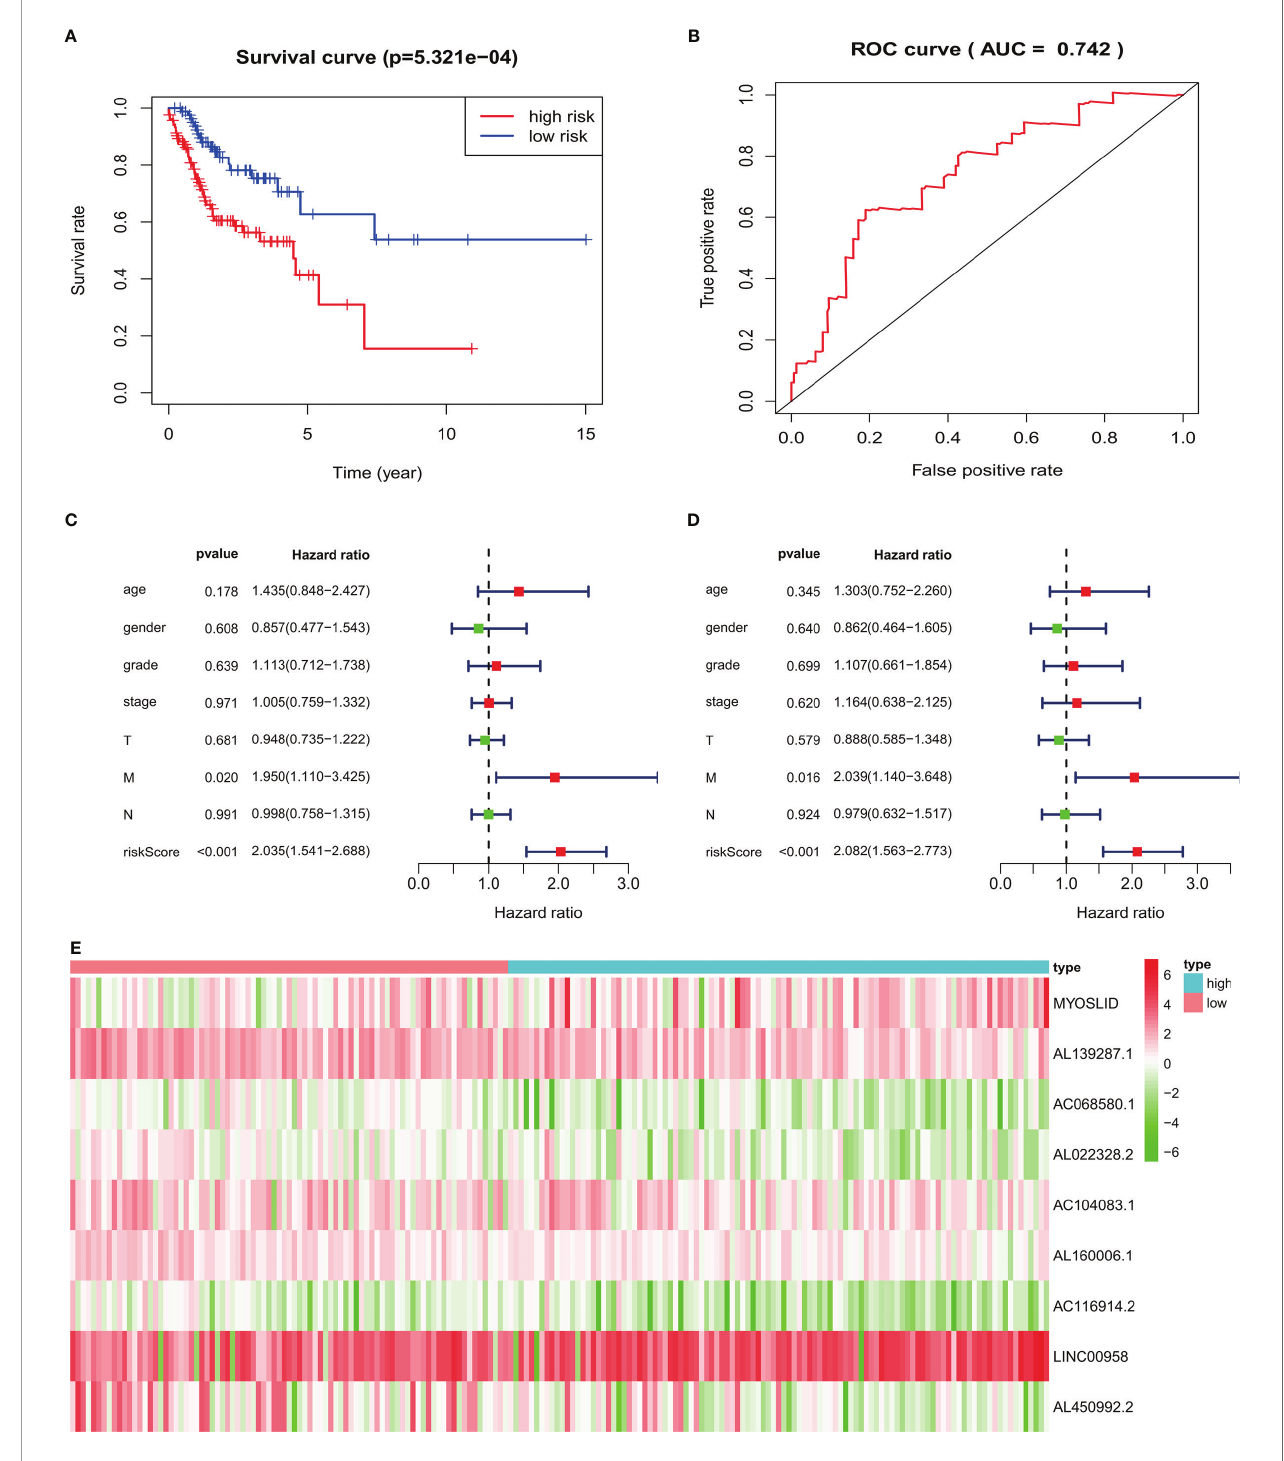
FIGURE 8 | Validation of prognostic signature in an independent HNSCC population: (A) high-risk HNSCC patients have poorer overall survival. (B) ROC curves of prognostic signature in validated HNSCC patients. (C, D) Forest plots of univariate and multivariate Cox regression, respectively, about association between risk score and overall survival in validated HNSCC patients. (E) Heatmap of nine target LncRNAs in high-risk and low-risk